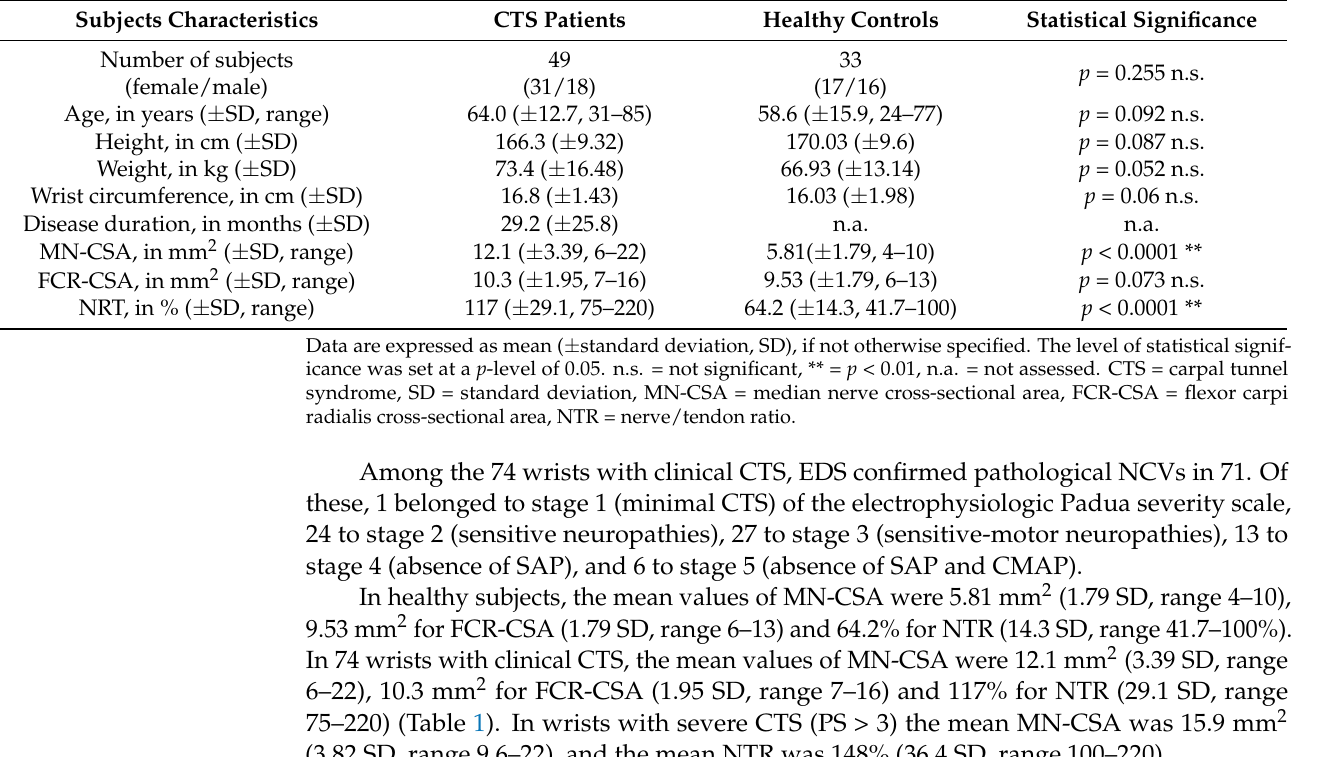
Table 1. Demographic, anthropometric, and clinical characteristics of patients and